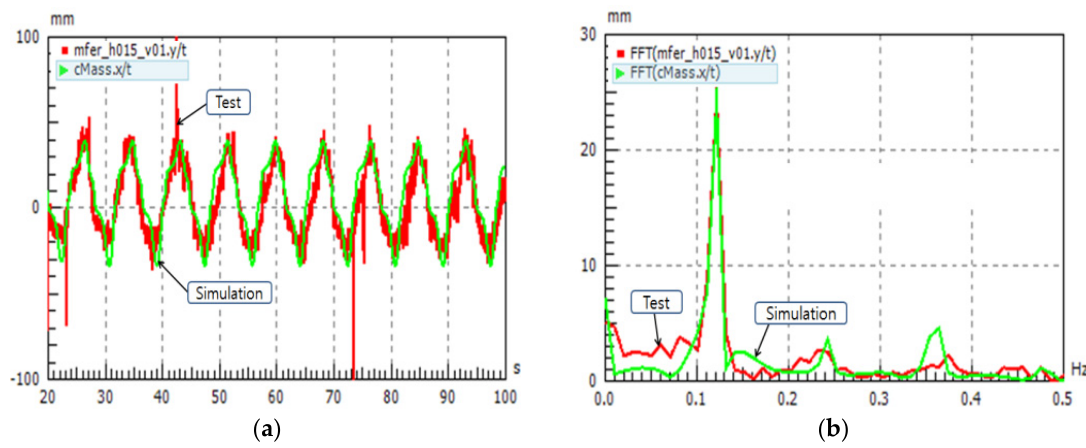
Figure 9. Comparison of test result and simulation result, ( a ) time data; ( b ) frequency characteristics.